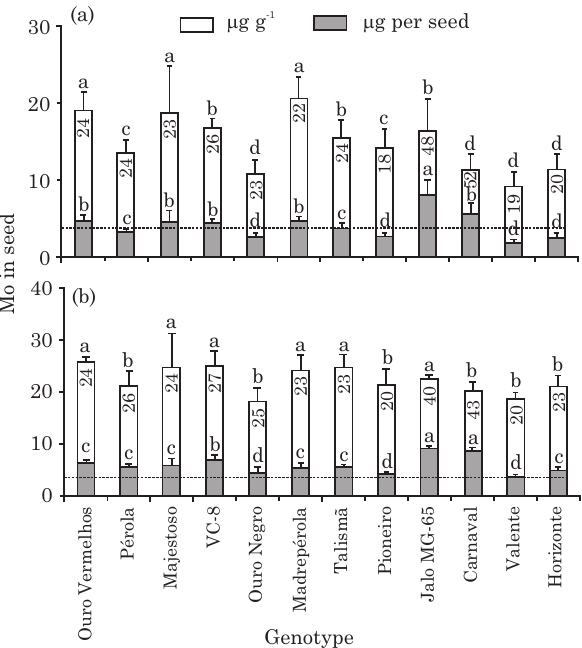
Figure 2. Effect of molybdenum (Mo) sprayed on 12 common bean genotypes at V4 (100 g ha -1 ), R5 (250 g ha - 1), and R7 growth stages (250 g ha -1 ) on the Mo seed concentration ( ) and content ( ) in the 2010 experiments in (a) Coimbra and (b) Oratórios. The filling of the white bars represents the 100-seed dry mass (in g). The seed Mo content (µg per seed) was calculed by multiplying the mass of one dry seed (in g) by the seed Mo concentration (in µg g -1 ). The horizontal dotted line represents the seed Mo content (3.6 µg) at which common bean does not respond to Mo fertilization (Vieira et al., 2011b). Thin bars represent the standard